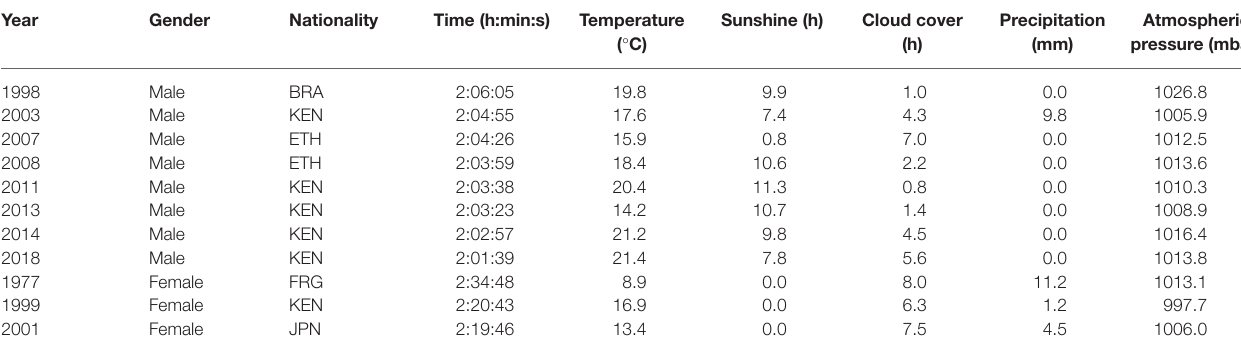
TABLE 1 | Marathon world record performances by year, gender, and weather conditions.